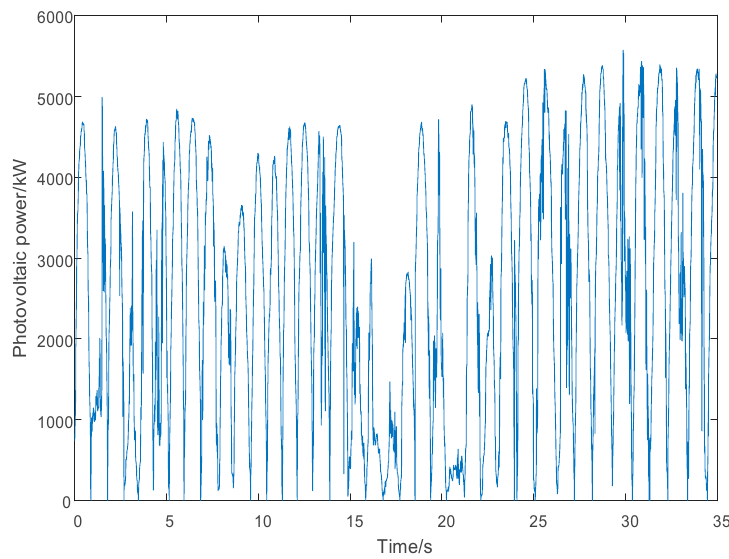
Figure 5. PV historical power time series.